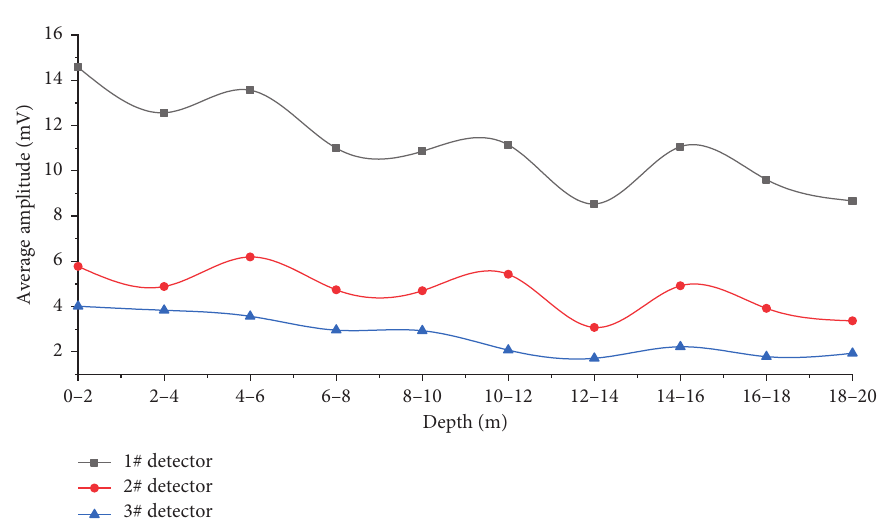
Figure 6: Variation curve of average amplitude with drilling